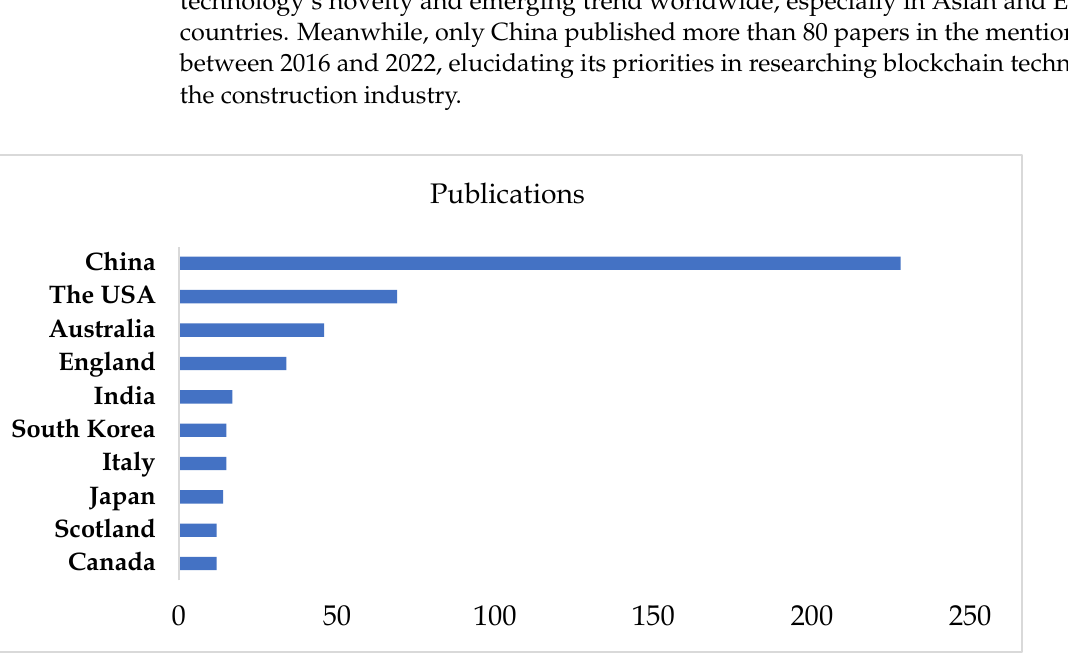
Figure 9. Network visualization of international collaboration. 3.4.2. Organizations The 482 articles containing institution information included participation from 676 different research organizations. Approximately 22% (148) of the organizations have pub ‐ lished at least two academic documents in the mentioned field. Thirty organizations (4.4%) published more than five papers on Blockchain in the construction industry, and merely four organizations (0.6%) published more than ten papers. Table 4 indicates the top ten most productive organizations/institutes publishing papers in the studied field. The majority of the productive universities (60%) are from China, making the country the first and top nation publishing the most papers in the field of Blockchain in the construc ‐ tion industry. Furthermore, The University of Hong Kong could be deemed the most pro ‐ ductive organization, with 14 articles, followed by the Chinese Academy of Sciences with 13 papers.